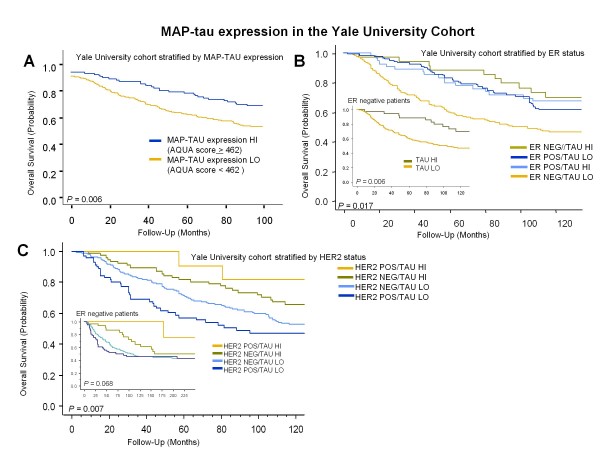
Kaplan Meier survival analysis and MAP-tau expression in Yale University cohort. (a) Ten-year survival for high MAP-tau expression versus low expression for all invasive breast carcinoma patients in the Yale University cohort (n = 651). Survival rate for patients classified as high MAP-tau expressors (n = 94) was 68.3% compared with 52.9% for low expressors (n = 339; log-rank, P = 0.006). (b) Kaplan Meier survival for MAP-tau expression stratified by eatrogen receptor (ER) status in the Yale University cohort. For ER-negative patients (inset), high MAP-tau expression (n = 35) showed improved survival compared with low (n = 209) expression. (c) Ten-year survival for MAP-tau expression stratified by human epidermal growth factor receptor (HER) 2 status in the Yale University cohort. Patients classified as high MAP-Tau expressors showed improved survival compared with low expressors, regardless of HER2 status. For ER-negative patients stratified by HER2 status (inset), ER-negative patients with high MAP-tau expression (n = 30) trended toward improved survival, regardless of HER2 status, compared with low MAP-tau expressors (n = 56) (68.4% v 45.3%; log-rank, P = 0.068).